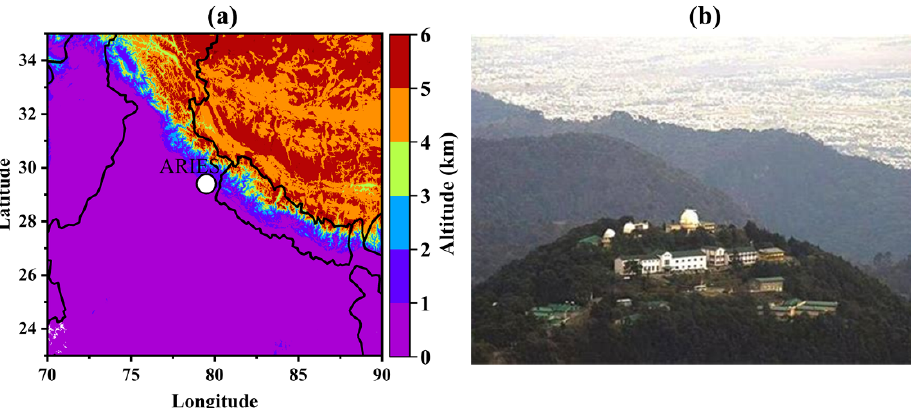
Figure 1. Topographical map showing the measurement location ( a ) and the aerial view observa- tional location (i.e., ARIES) with the Indo-Gangetic Plain in the background ( b ). location (i.e., ARIES) with the Indo-Gangetic Plain in the background ( b